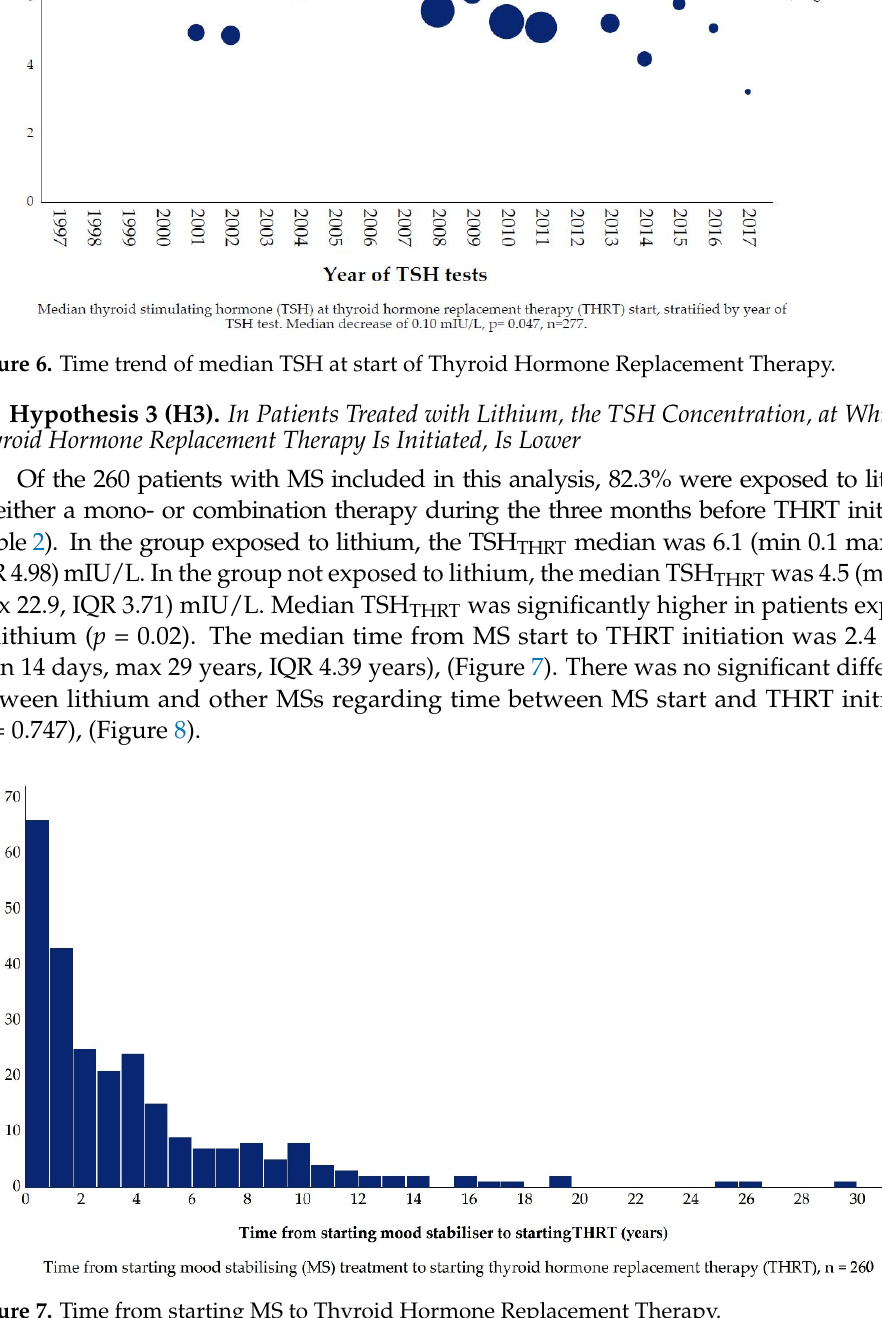
Figure 6. Time trend of median TSH at start of Thyroid Hormone Replacement Therapy.